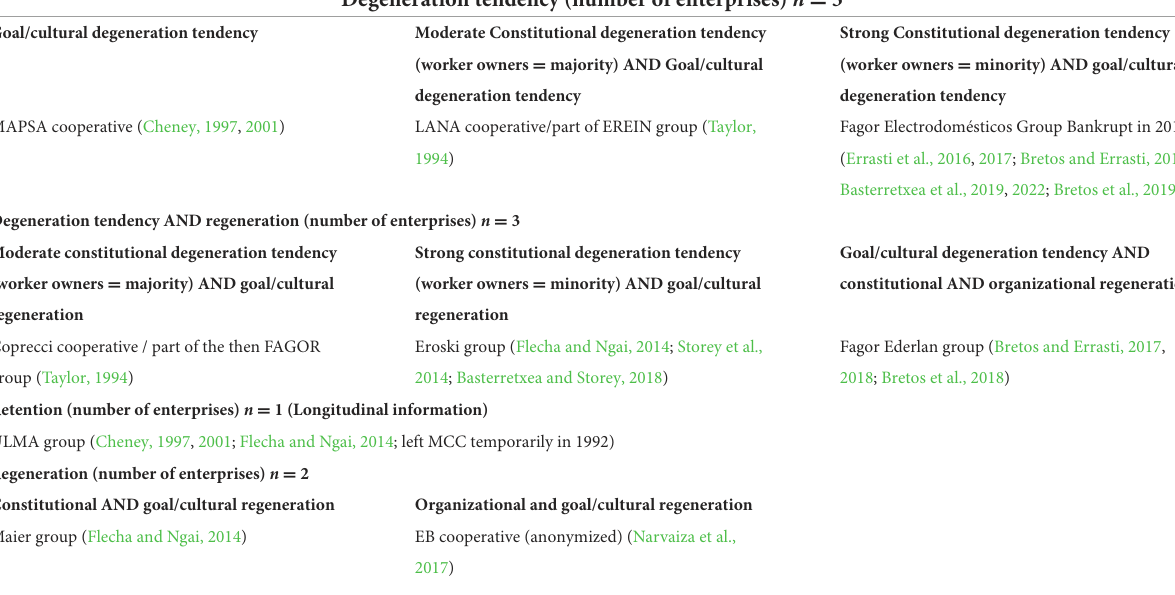
TABLE 6 Number of enterprise cases per transformation form from the Mondragon Cooperatives